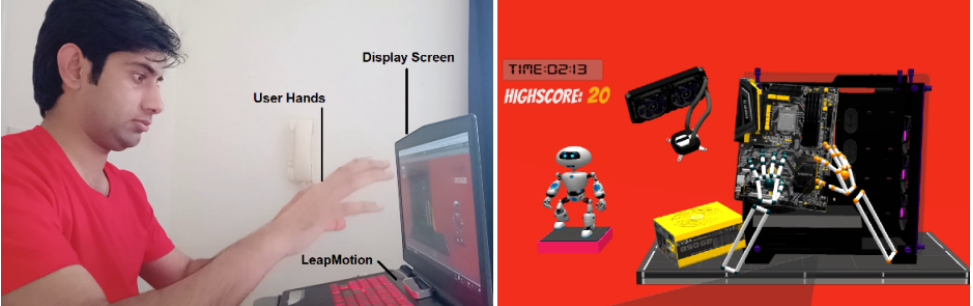
Figure 10. Touchless hand interaction for learning PC assembly using Leapmotion hand